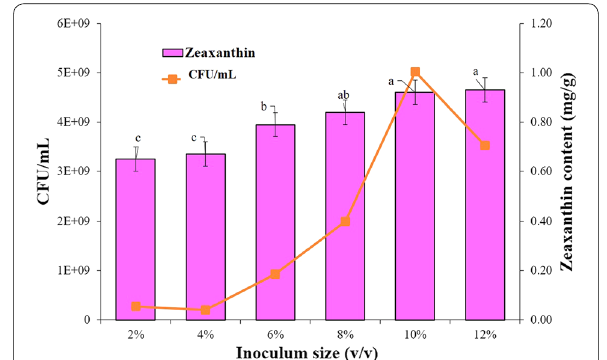
Fig. 4 Effect of different inoculum size (v/v) on the zeaxanthin accumulation and DCW by A. gandavensis MTCC 25325 after 72 h. All statistical significance comparisons between indicated groups were performed using a one-way ANOVA with Fisher’s post-test. Data presented are mean values and their standard deviation